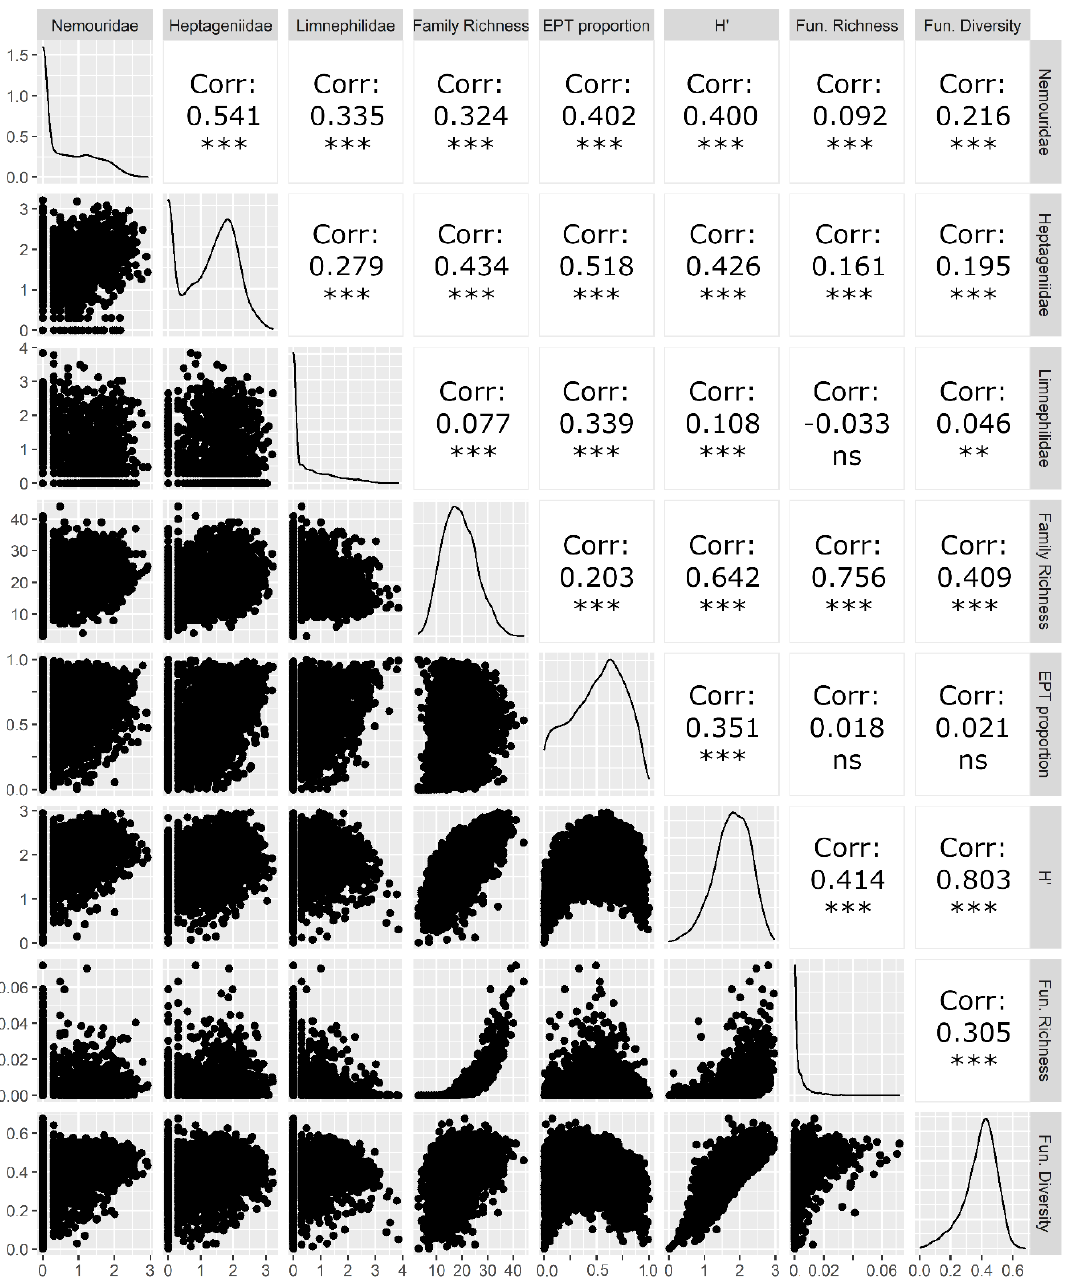
Figure 4. Correlation among macroinvertebrate communities metrics and indices. The diagonal represents the density function of each metric or index, below the diagonal the pairs plot are presented and above the diagonal the Pearson’s correlation between each pair of metrics and indices is reported along with the significance levels. Levels of statistical significance are as follows: ***, p < 0.001; **, p < 0.01; ns, p >